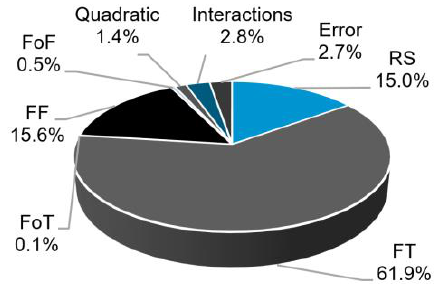
Figure 8. Contributions of the model factors to the response H.